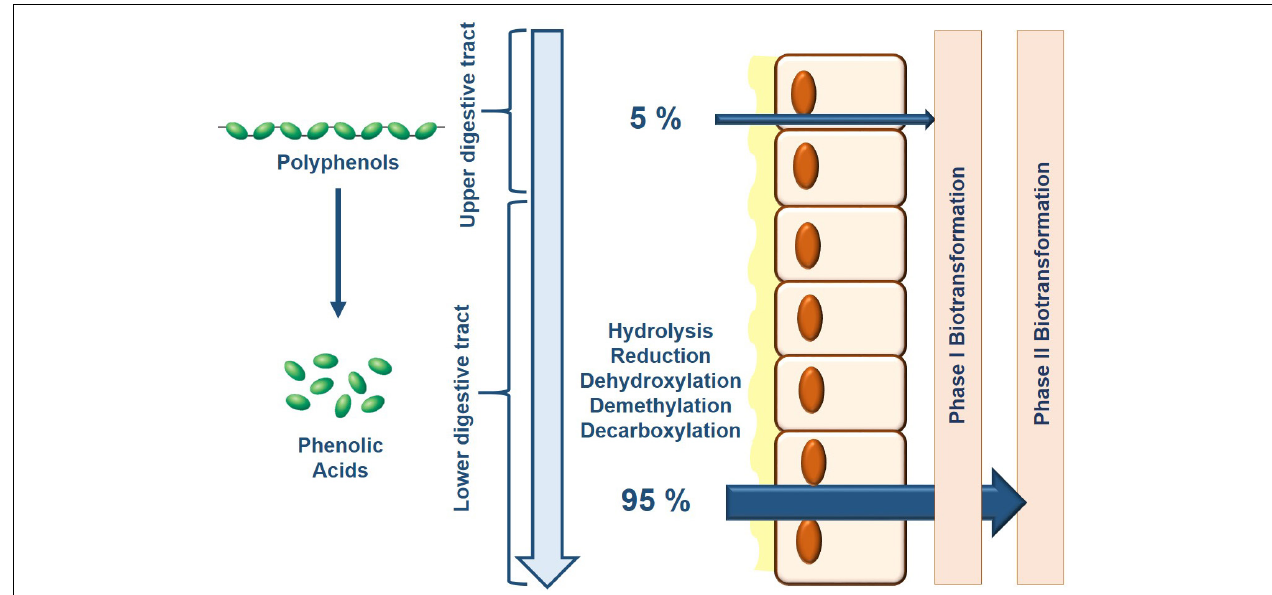
FIGURE 1 | Bioavailability of dietary polyphenols is primarily determined by the composition of the gut microbiota. As consumed, only 5% of dietary polyphenols are absorbed where consequently, Phase I and Phase II biotransformation takes place in the epithelial cells and liver which generates a limited battery of bioavailable metabolites. Upon reaching the lower colon, the gut microbiota breaks down the remaining dietary polyphenols through their endogenous enzymatic activity increasing their relative bioavailability for downstream processing by Phase I and Phase II